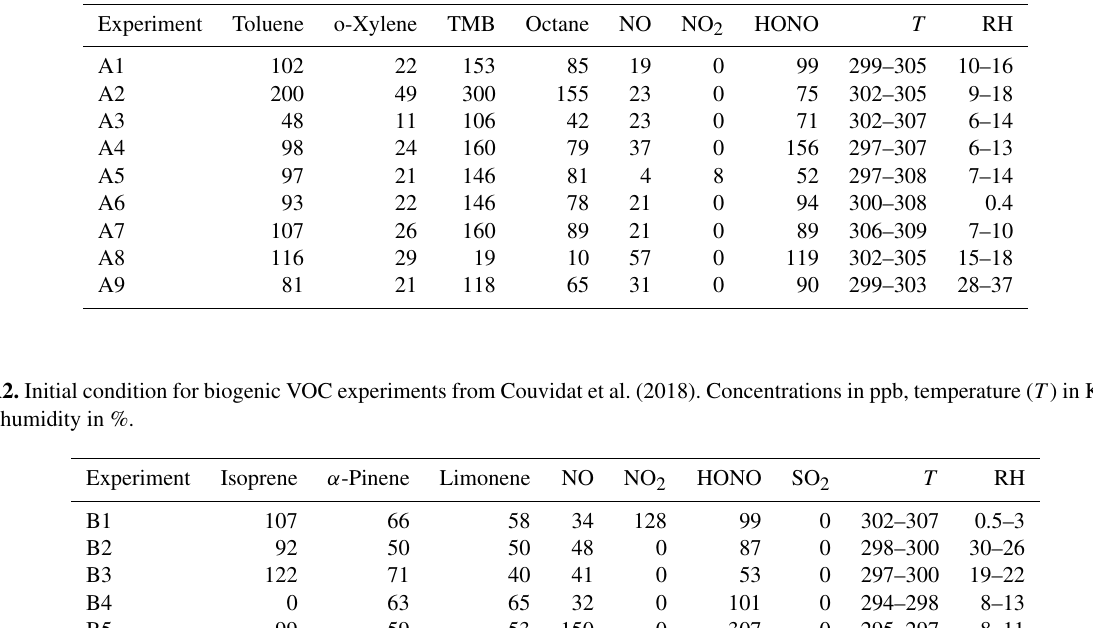
Table A1. Initial condition for anthropogenic VOC experiments from Couvidat et al. (2018). Concentrations in ppb, temperature ( T ) in Kelvin and relative humidity in %.